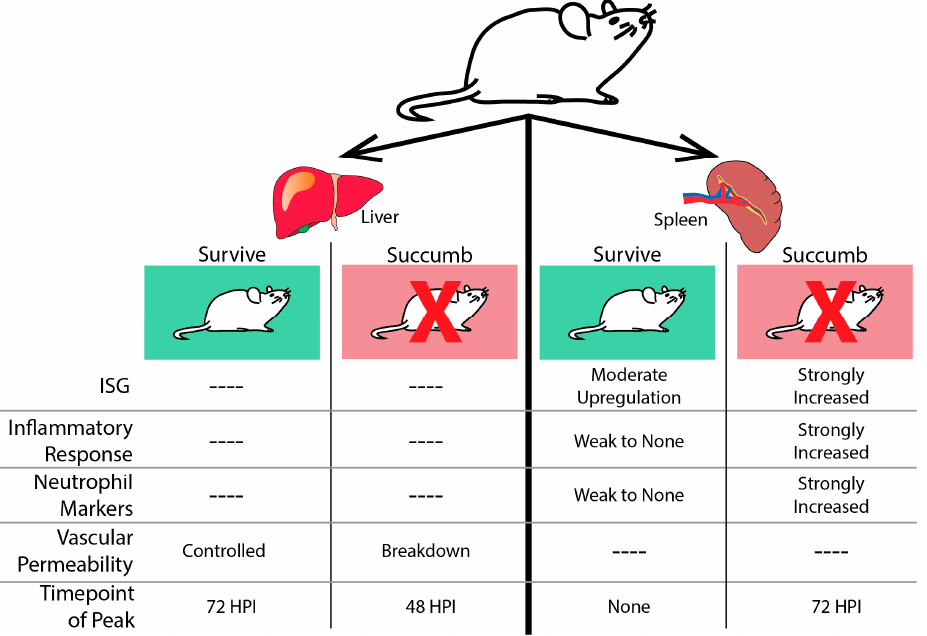
Figure 3. The host transcriptional response to EBOV infection in mouse liver and spleen. In the liver (left), all mice challenged with EBOV show transcriptional changes. Animals that succumb experience a peak point of transcriptional activity at 48 h post-infection (HPI.). Genes are enriched for transcripts associated with loss of vascular permeability. Surviving mice do not experience a peak of transcriptional activity until 72 HPI and do not induce genes associated with the breakdown of the vascular layers. In the spleen (right), all animals challenged with EBOV mount a transcriptional response to infection. In animals that will succumb to disease, peak transcriptional activity is observed at 72 HPI. These transcripts are associated with a strong induction of ISGs, the inflammatory response, and evidence of neutrophil infiltration. In animals that survive, there are lower levels of transcriptional activity throughout infection. There is moderate up-regulation of ISGs and a weak inflammatory response.